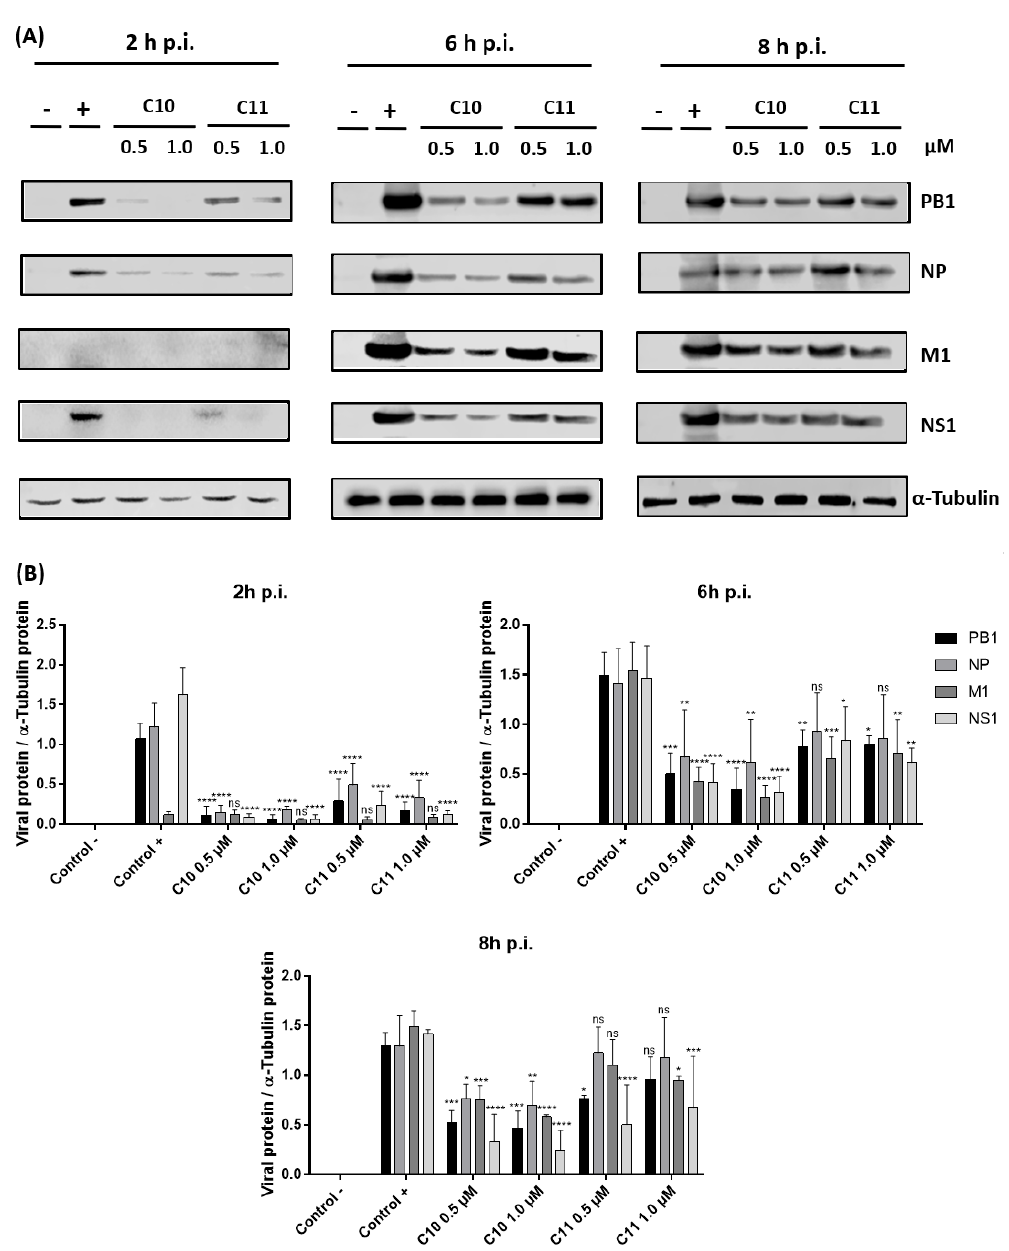
Figure 3. ( A ) Effects of C10 and C11 on influenza A virus (strain A/WSN/33 (H1N1)) protein expression over time. Western blot analysis occurred of MDCK cells infected at MOI 5 and then treated with both compounds (0.5 and 1.0 µ M). Cell lysates were collected 2, 6, and 8 h post-infection (p.i.), run on SDS-PAGE 10%, and analyzed using specific antibodies for viral (PB1, nucleoprotein (NP), M1, and NS1) proteins. Equal protein loading was confirmed by probing for α -Tubulin. MDCK cells not infected or treated were used as negative control ( − ). MDCK cells infected and just DMSO-treated (solvent control) were used as positive control ( + ). ( B ) The graph indicates the ratio of each viral protein to α -Tubulin protein (ns = no significant, * p < 0.05; ** p < 0.01; *** p < 0.001; and **** p < 0.0001 vs. the respective viral controls, two-way ANOVA, post hoc test